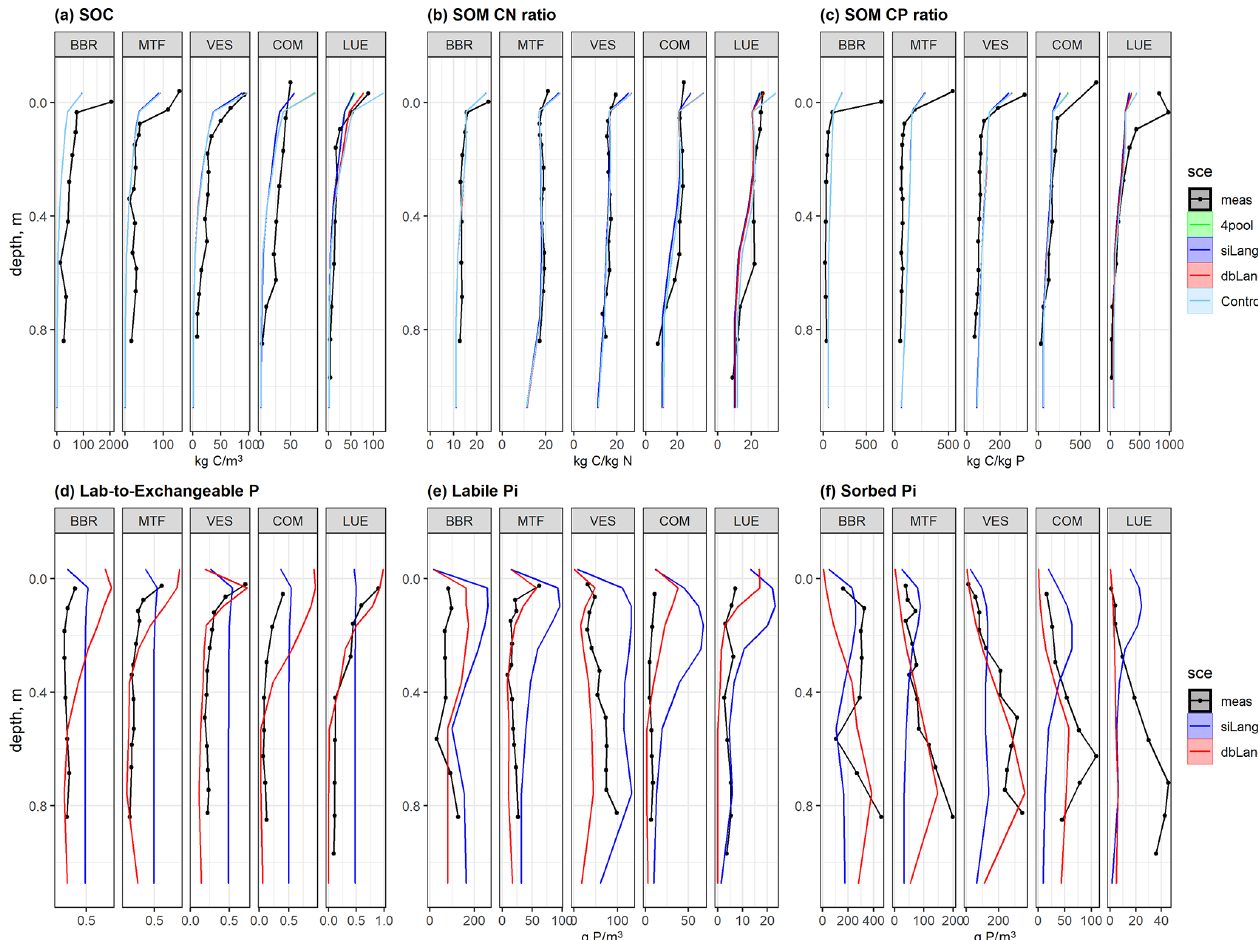
Figure 3. Simulated and measured (a) soil organic carbon (SOC), soil organic matter (SOM) (b) C:N and (c) C:P ratios, (d) ra- tio of labile to exchangeable Pi, (e) labile Pi, and (f) sorbed Pi of the study sites along the following soil P availability gradient: BBR > MTF > VES > COM > LUE. The black dotted line is the field measurements, the lime line represents the Langmuir model with only four inorganic P pools (4pool), the blue line represents the single-surface Langmuir model (siLang), the red line represents the double- surface Langmuir model (dbLang), and the light sky-blue line represents the Control model. The 4pool and Control simulations are not applicable in panels (d) , (e) , and (f)